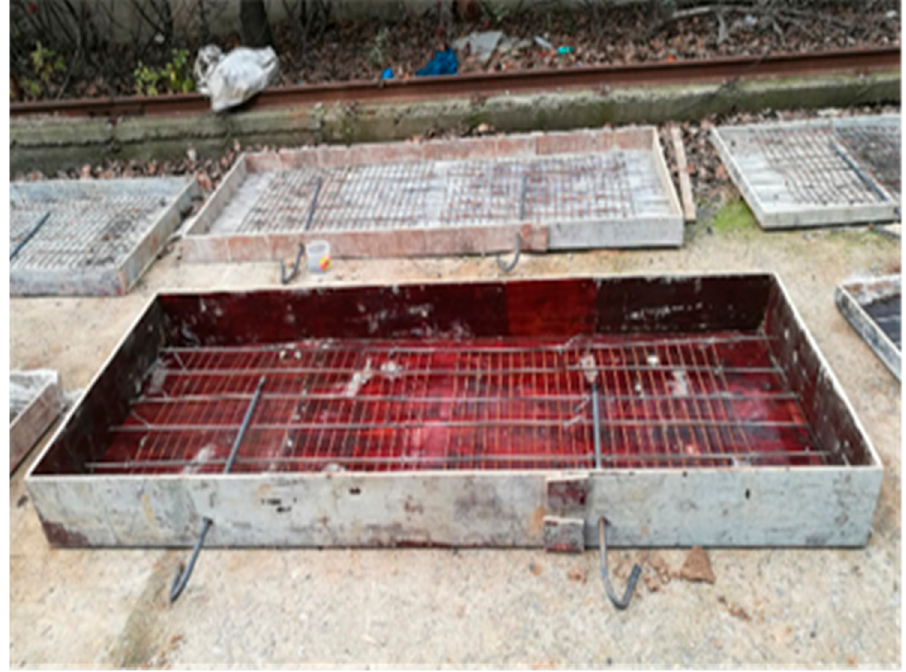
Figure 4. Mold making and steel binding.